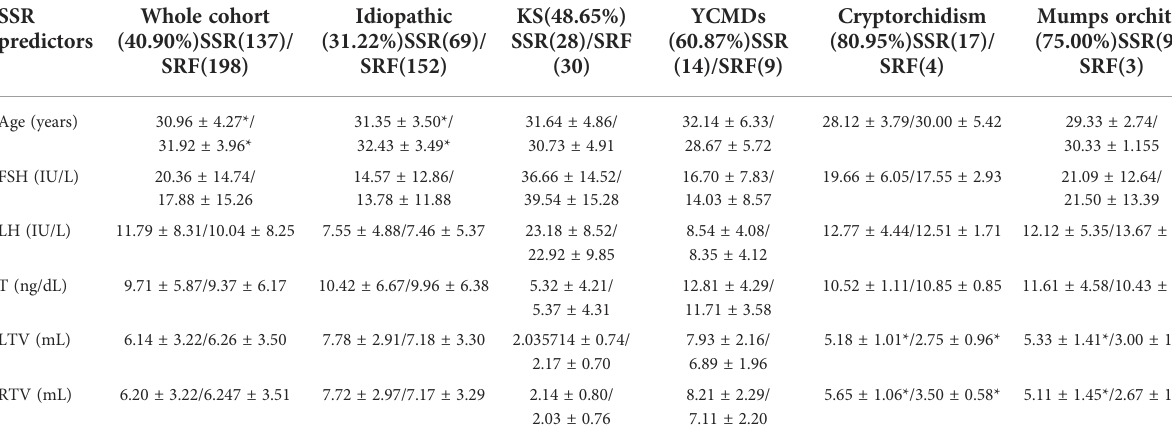
NOA, nonobstructive azoospermia; FSH, follicle stimulating hormone; LH, luteinizing hormone; T, testosterone; LTV, left testicular volume; RTV, right testicular volume; KS, klinefelter syndrome;YCMDs,Ychromosomemicrodeletions;SSR,successfulspermretrieval;SRF,spermretrievalfailure.*indicatedsigni fi